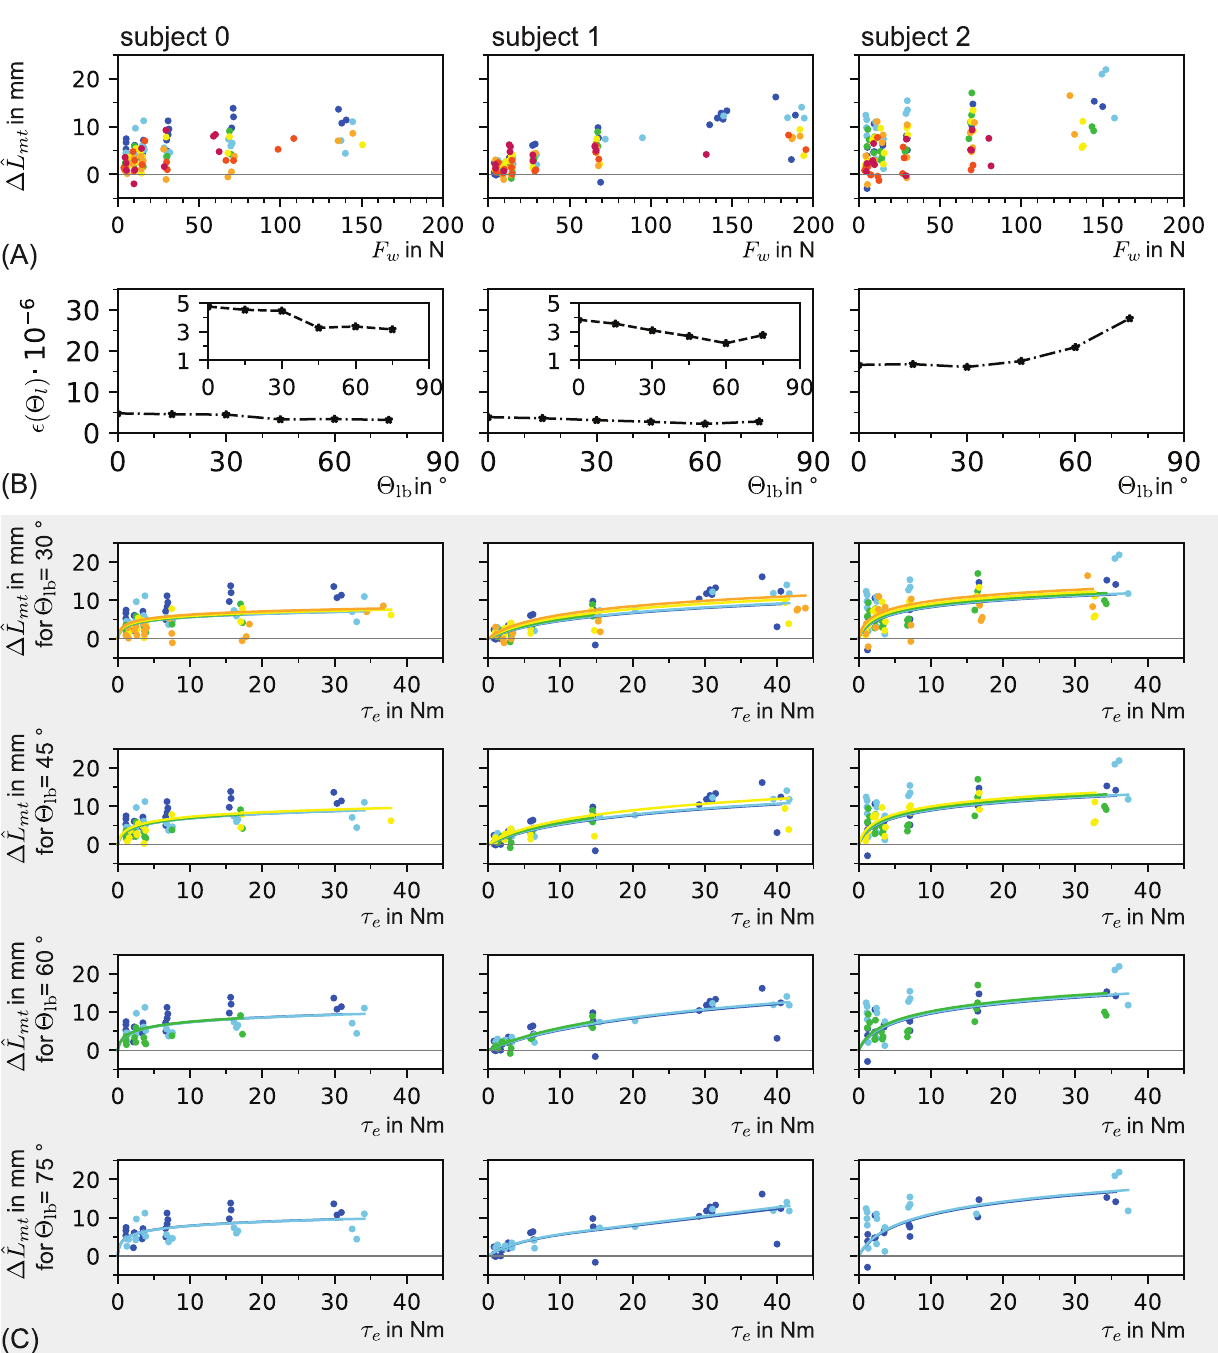
Fig 13. Fits on (semi-) automatically extracted data for three subjects in column-wise arrangement. (A) Myotendinous junction displacement D ^ L which is (semi-) automatically extracted from B-Mode videos plotted over the wrist force F (C) Fits of the angular subsets Θ lb = 30 � , Θ lb = 45 � , Θ lb = 60 � , Θ lb = 75 � . (Same color coding as in Fig 7).